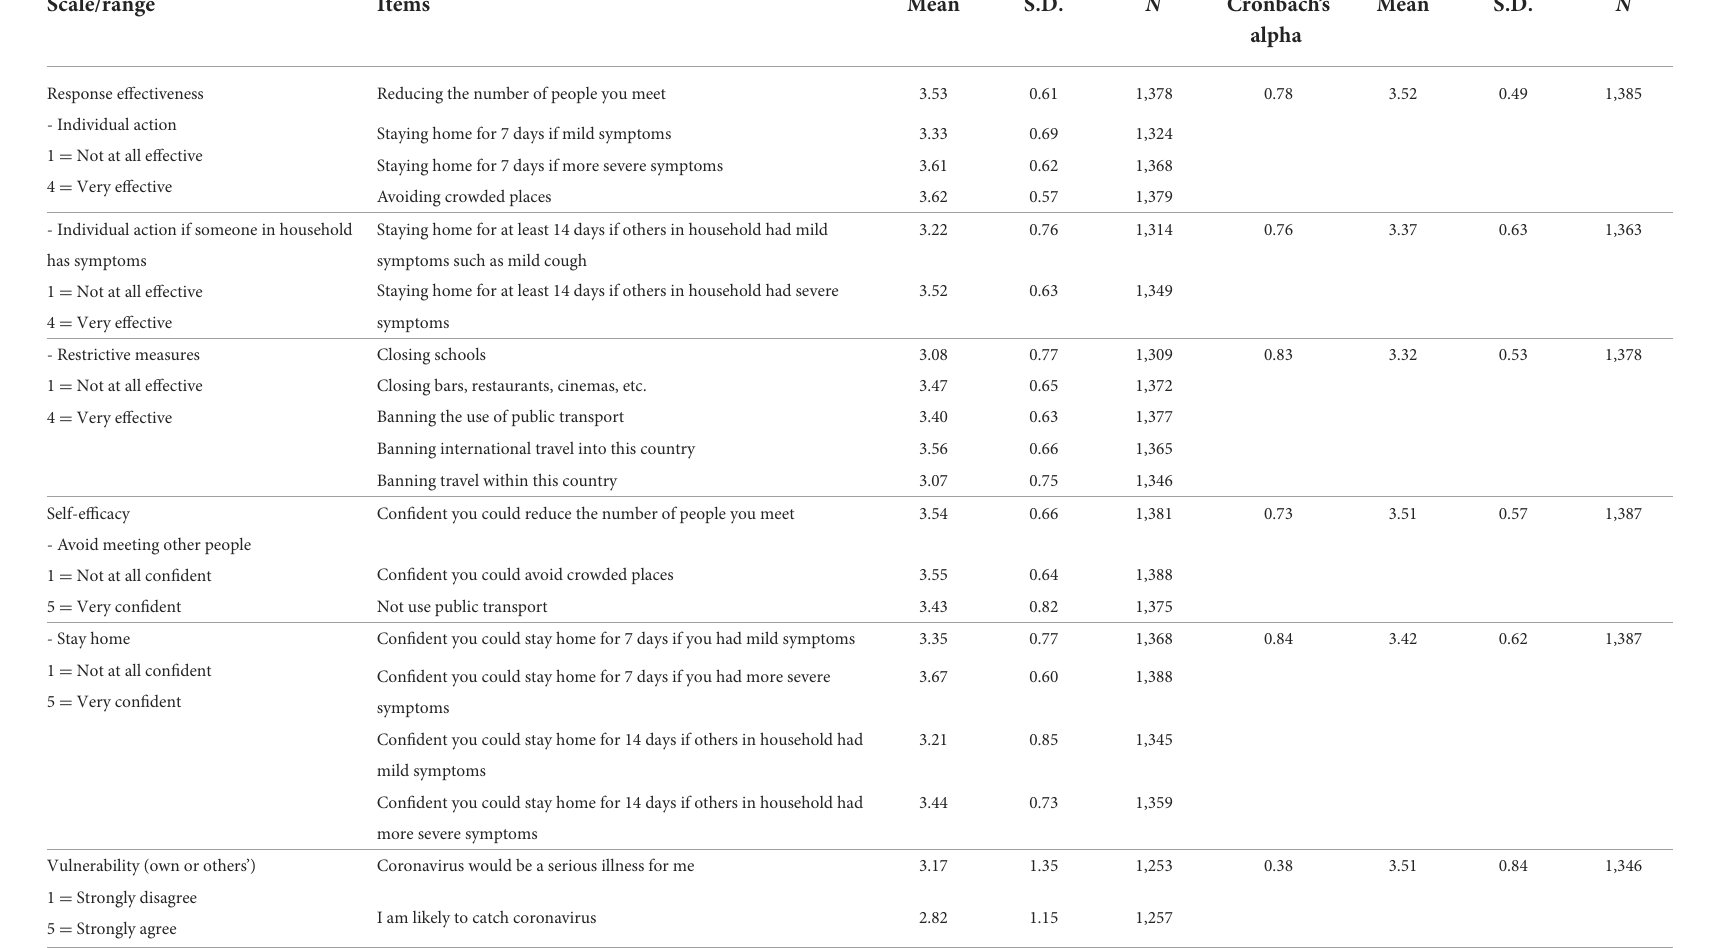
TABLE 3 Single item and meanscore descriptives at Wave 1.